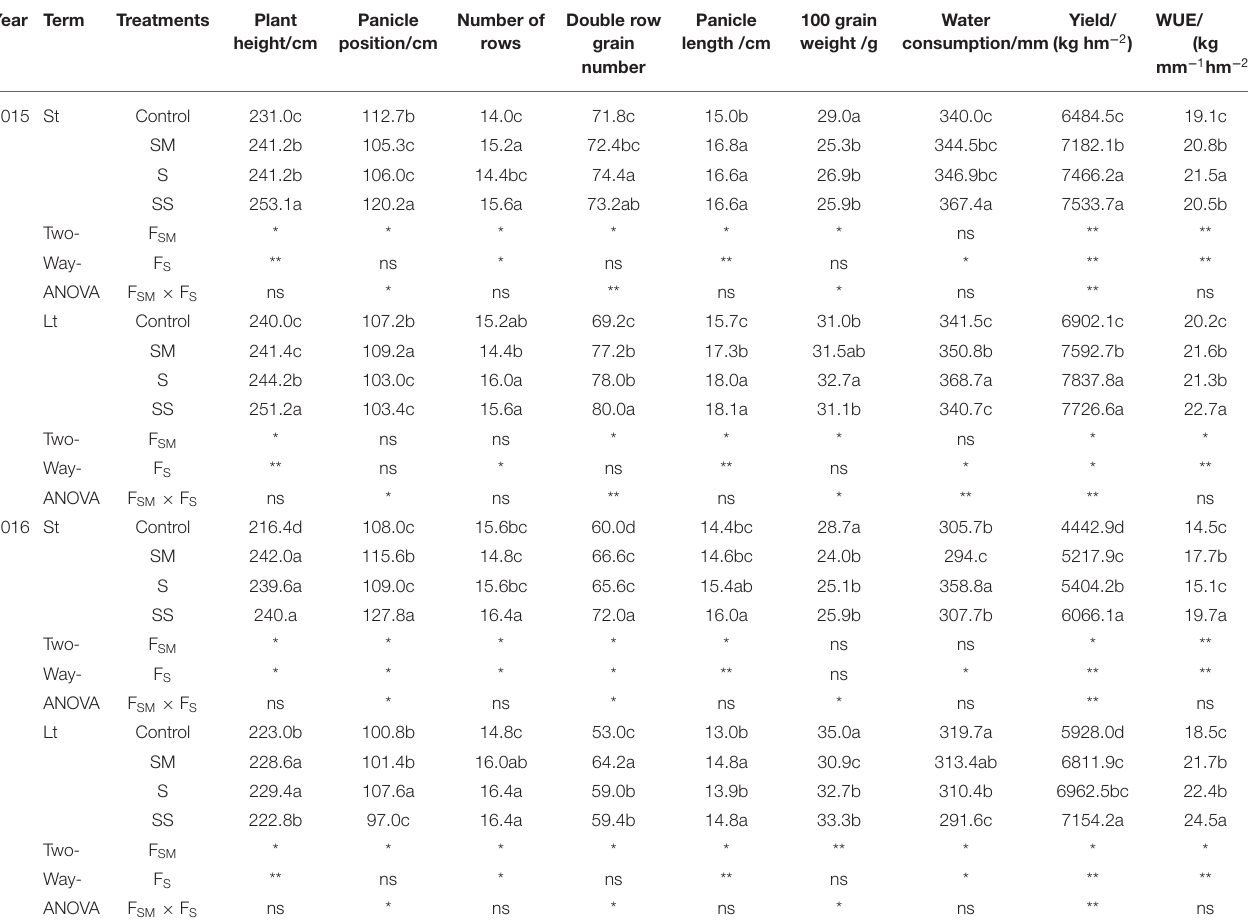
TABLE 5 | Yield and water use efficiency and yield component of maize under the Control, SM, S and SS treatments in different years.